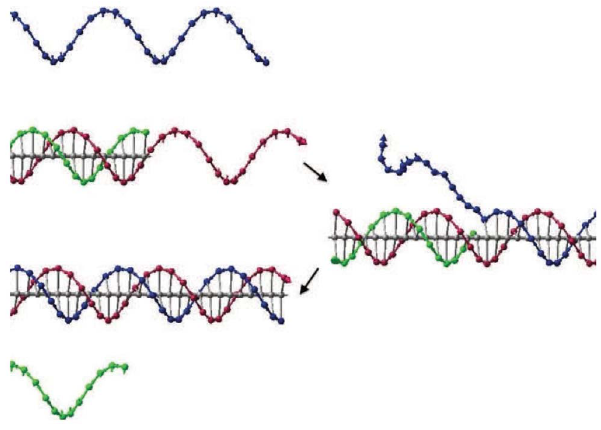
Figure 2. Irreversible DNA strand